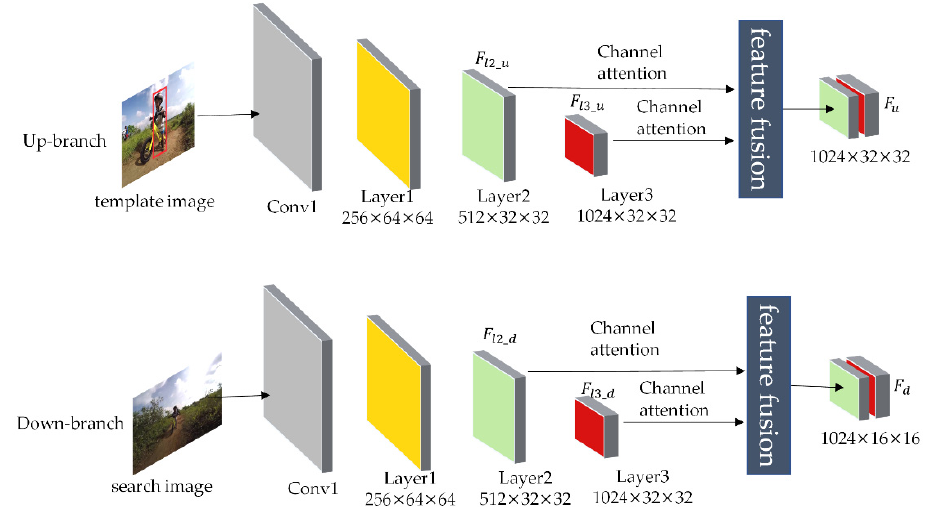
Figure 2. Diagram for fusion of shallow features and deep features.